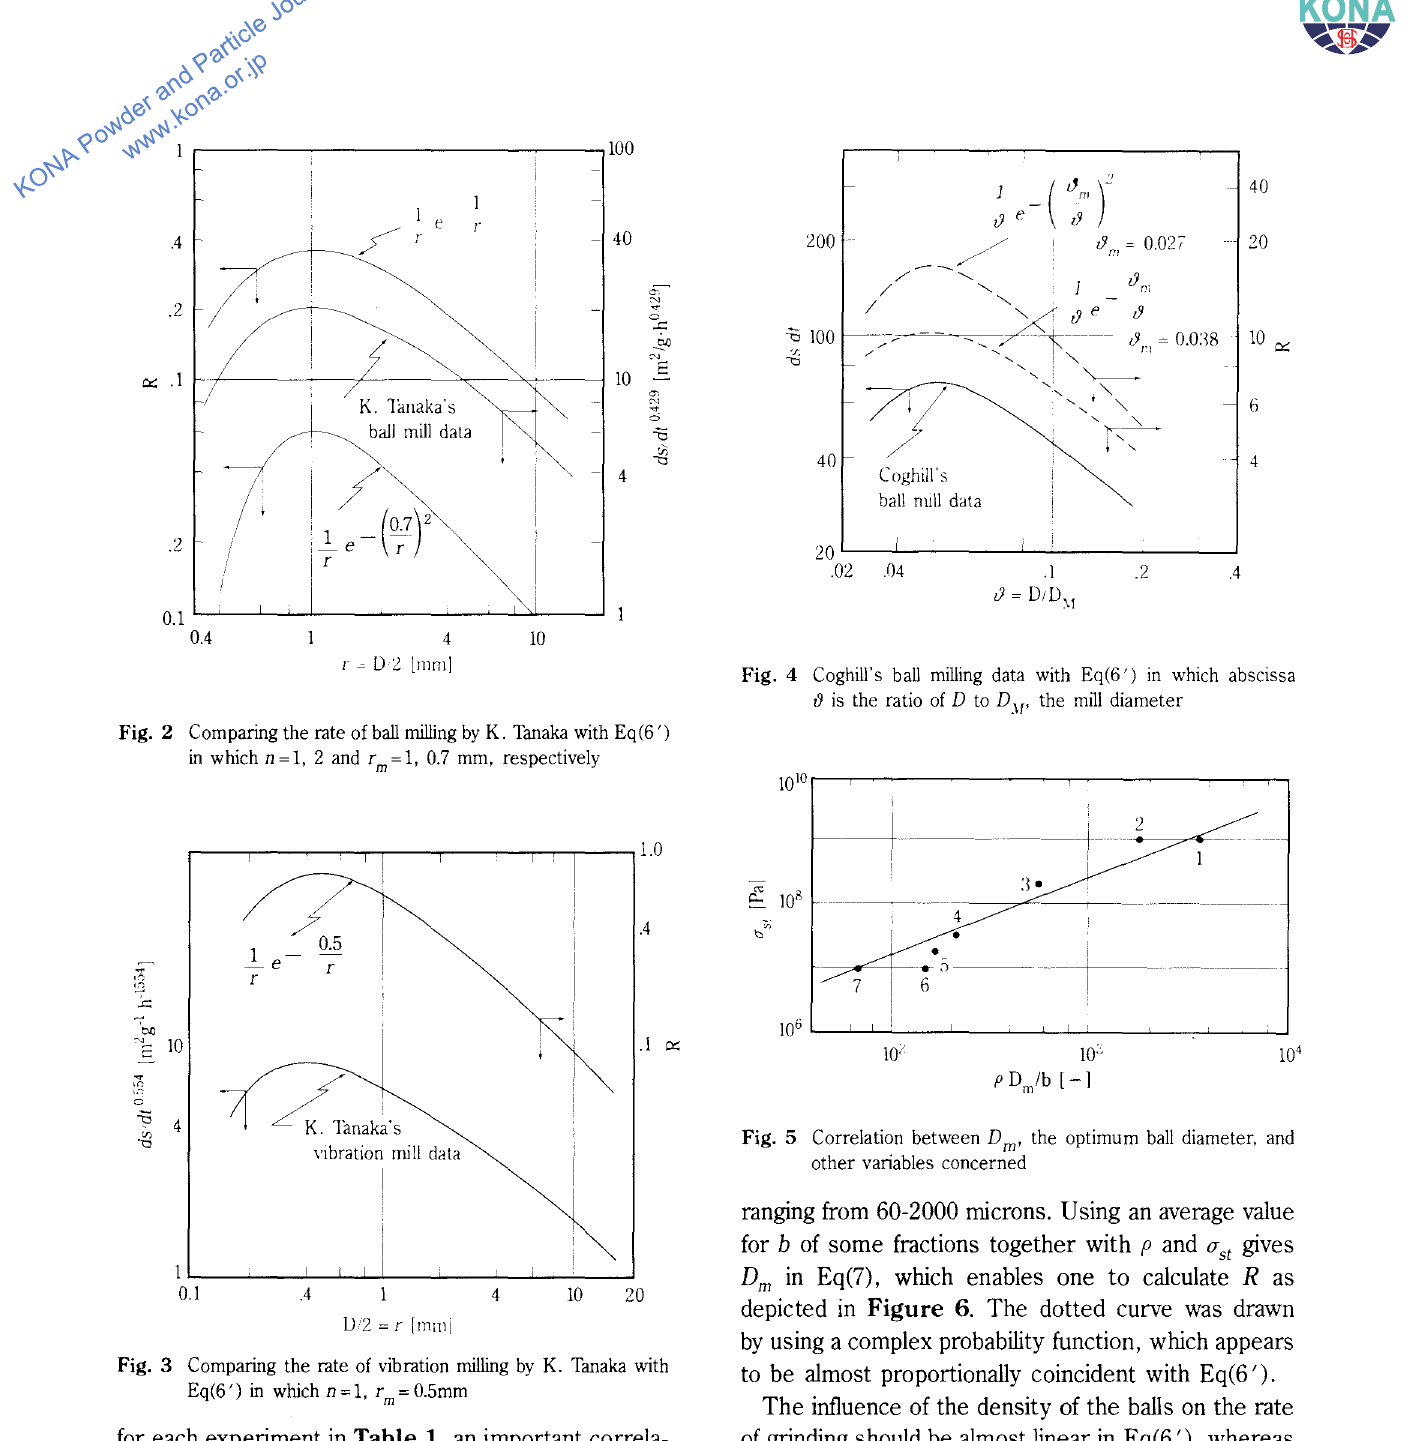
where SI units are used for p (kg/m 3 ) and f/st (Pa) under v = 1 - 2 m/s. Since f/